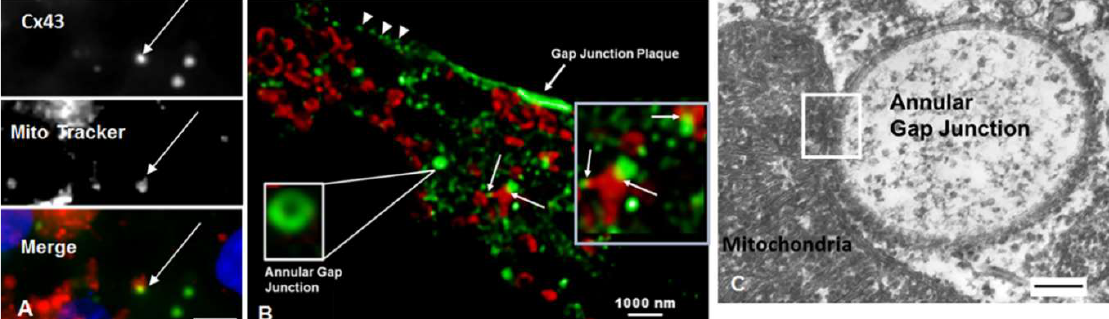
Figure 4. Mitochondria associate with annular gap junctions as seen with standard light ( A ), super-resolution STED ( B ), and TEM microscopy ( C ). ( A , B ) Immunocytochemical analysis of mitochondria, with Mitotracker (red in ( A )) or with antibody to TOM (red in ( B )) and endogenous Cx43 gap junction antigen detected with antibody staining (green in ( A , B )). The colocalization (yellow, white arrows) of mitochondria (red) and annular gap junctions (green) can be seen. ( B ) Note the gap junction plaque as well as small puncta at the cell surface (arrowheads) that are indicative of gap junction plaque formation. The image in ( B ) has been magnified three times (boxes) to show the lumen of an annular gap junction vesicle and the contact between mitochondria and annular gap junctions yellow, white arrows). ( C ) The intimate association between the mitochondria and annular gap junction (white box) seen with TEM. Scale bars = ( A ): 10 µ m, ( B ): 1000 nm, ( C ) 100